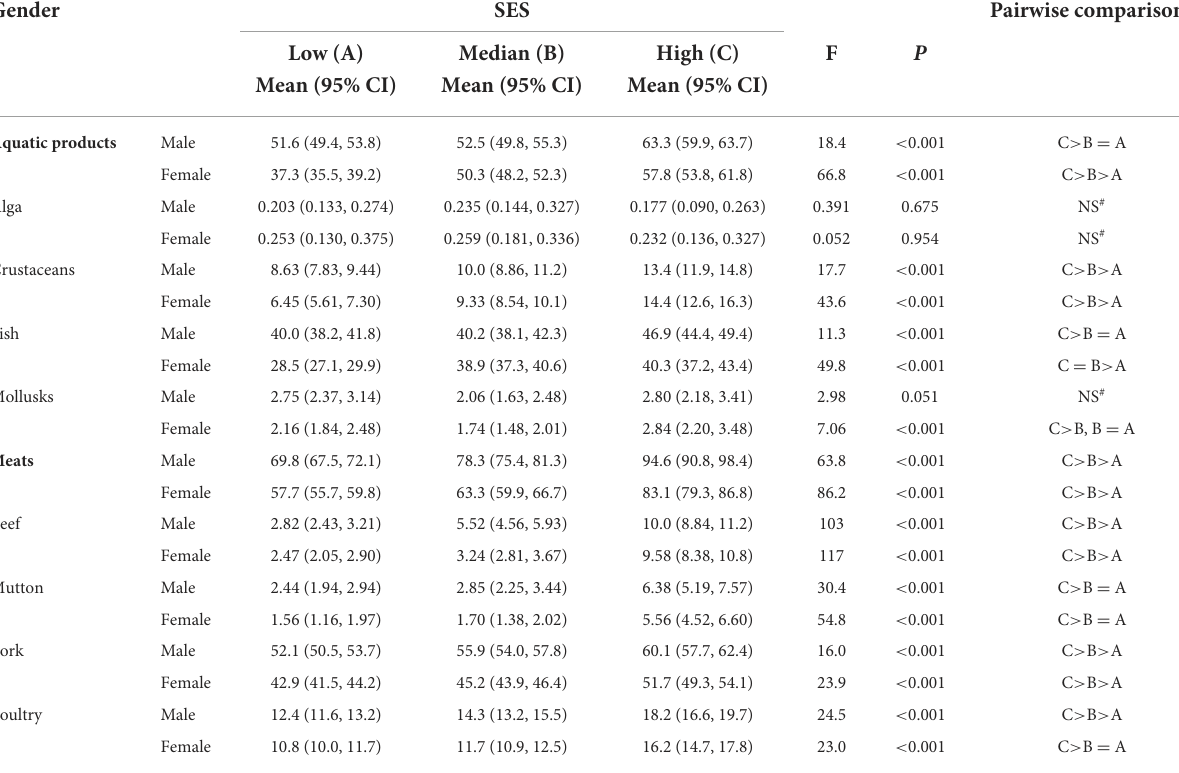
TABLE 5 Consumption of aquatic products and meats by gender and socioeconomic status (SES) grouping ( n = 17,010) *